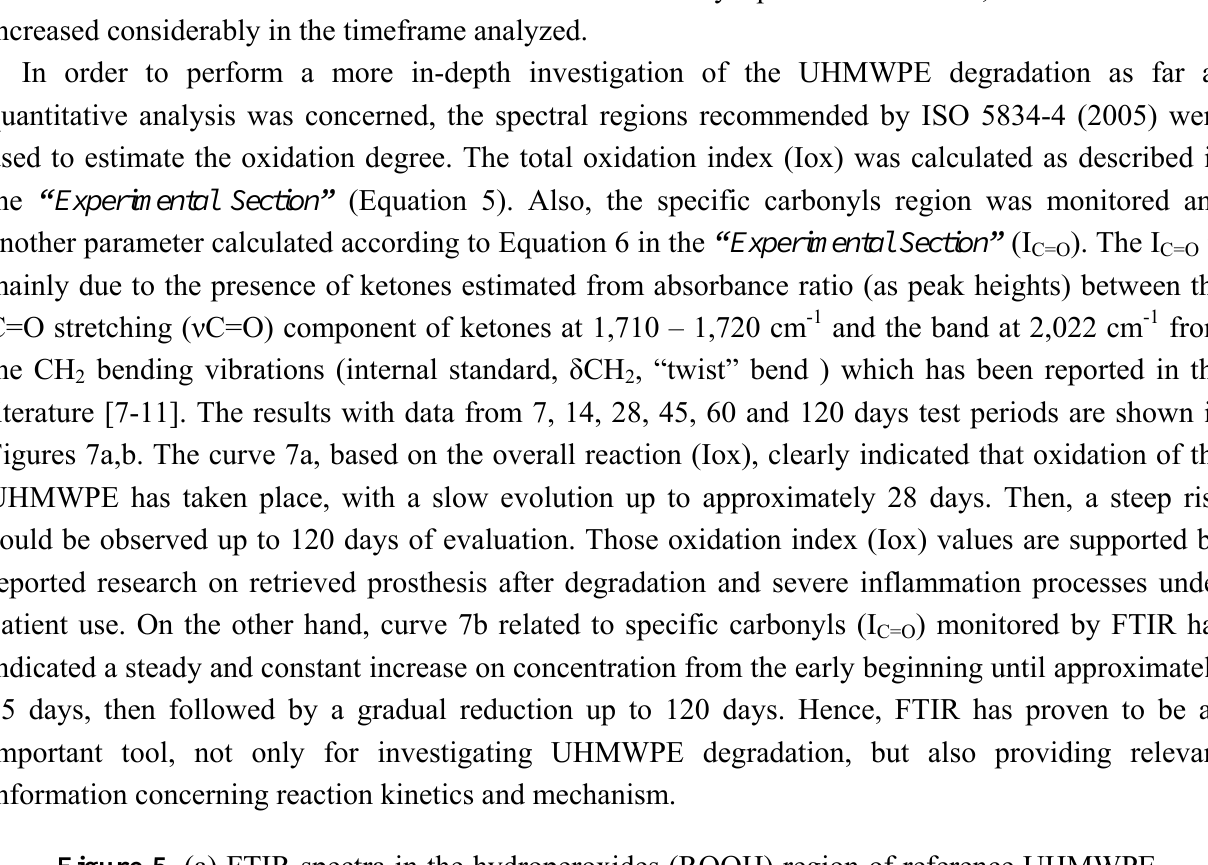
Figure 5. (a) FTIR spectra in the hydroperoxides (ROOH) region of reference UHMWPE and UHMWPE submitted to peroxide accelerated ageing for different period of time (b)